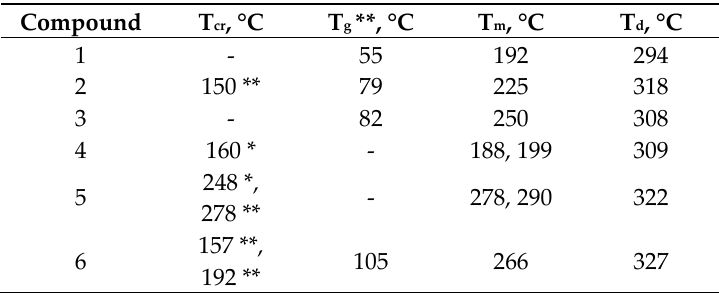
Table 1. Thermal characteristics of compounds 1 – 6 .